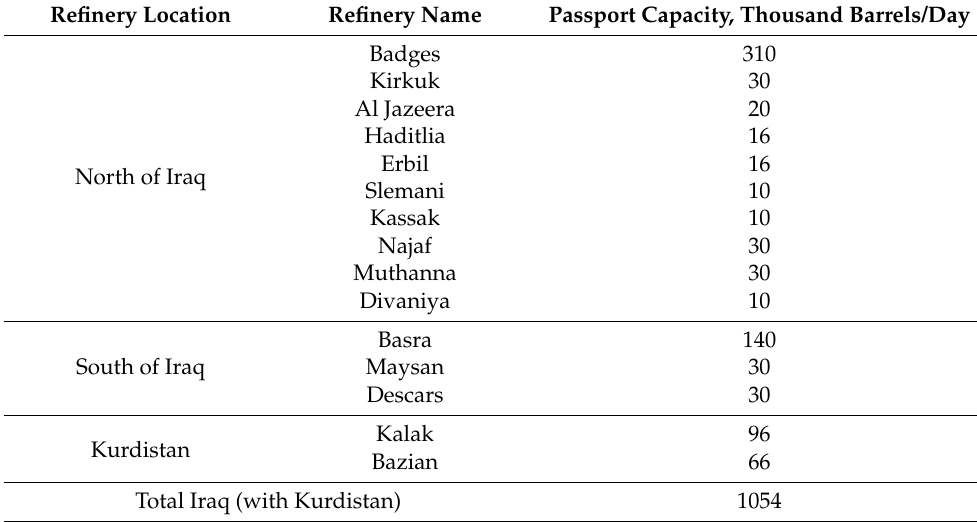
Table 5. Oil refineries in operation in Iraq, 2019.